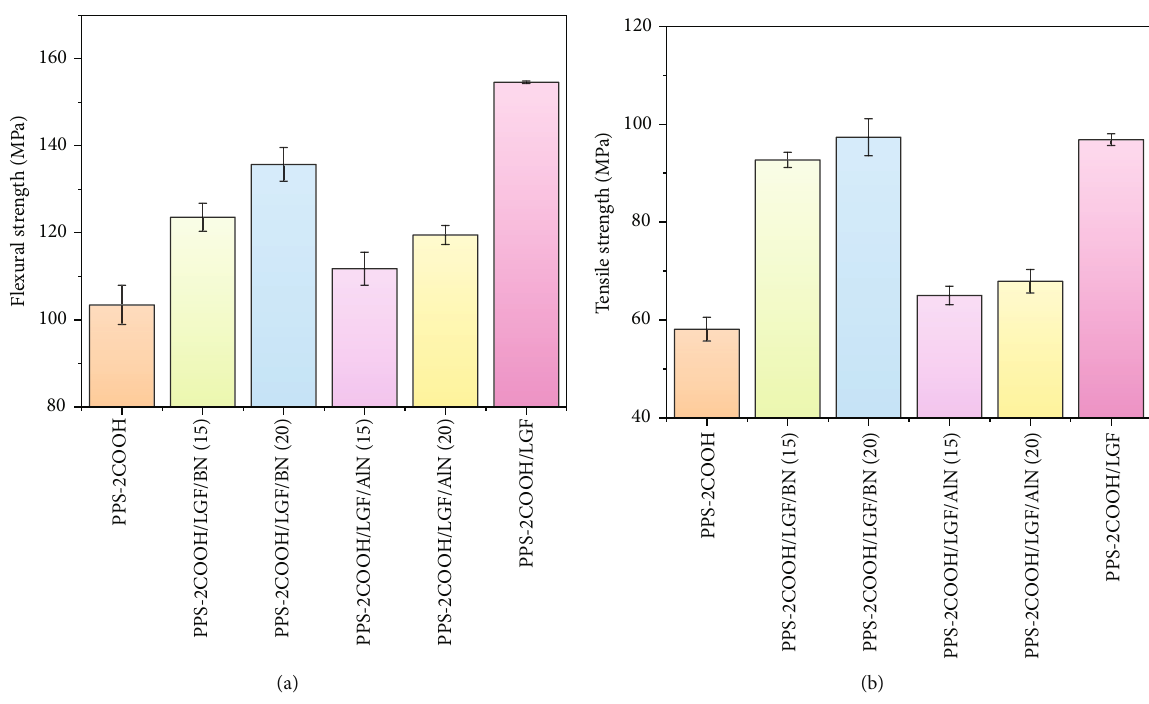
Figure 3: (a) Flexural strength and (b) tensile strength of PPS-2COOH, PPS-2COOH/LGF/BN, and